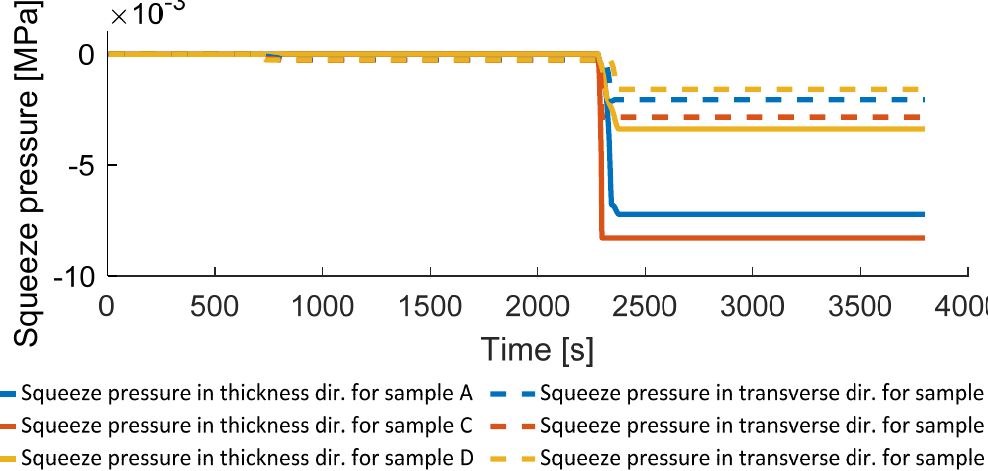
Figure 17. Squeeze pressures transverse to fiber and thickness directions.